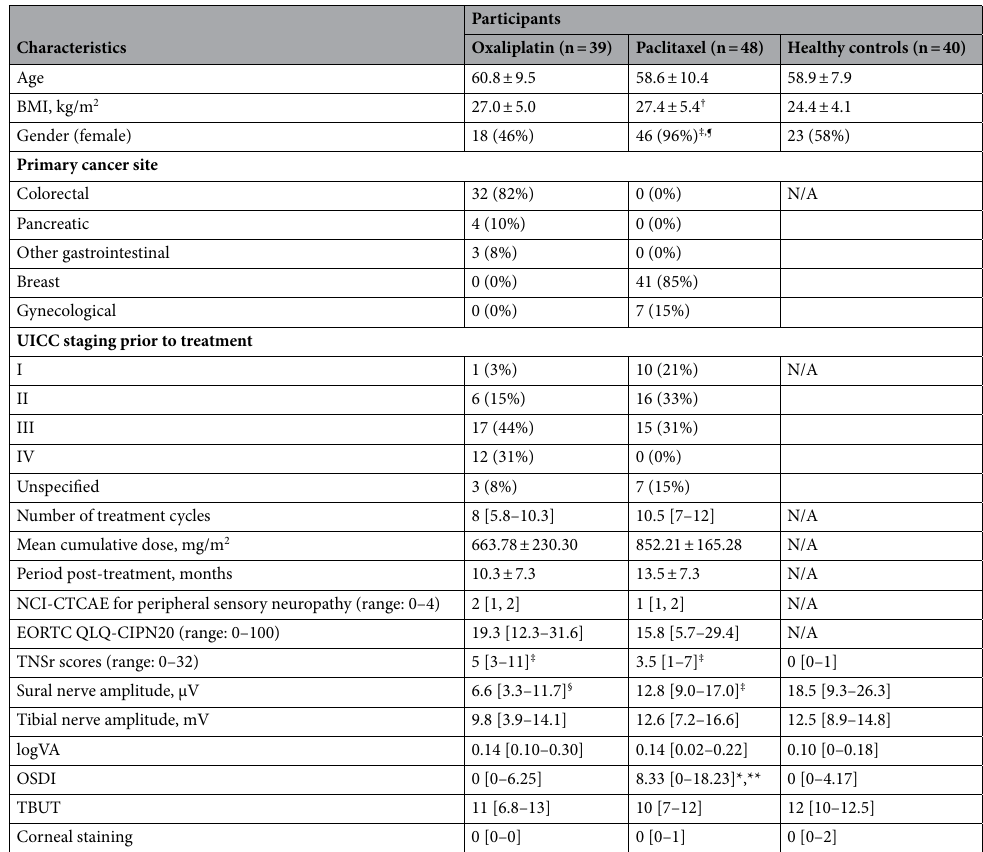
Table 1. Demographic, ocular surface measures, corneal nerve and neuropathy measures of patients who received oxaliplatin or paclitaxel for cancer treatment. Data is presented as mean ± standard deviation or median [interquartile range Q1–Q3]. Compared with healthy controls: † p = 0.02; ‡ p < 0.001; § p = 0.002; **p = 0.001; ***p = 0.007; ****p = 0.003; *****p = 0.006. Compared with oxaliplatin group: ¶ p < 0.001; *p = 0.008.